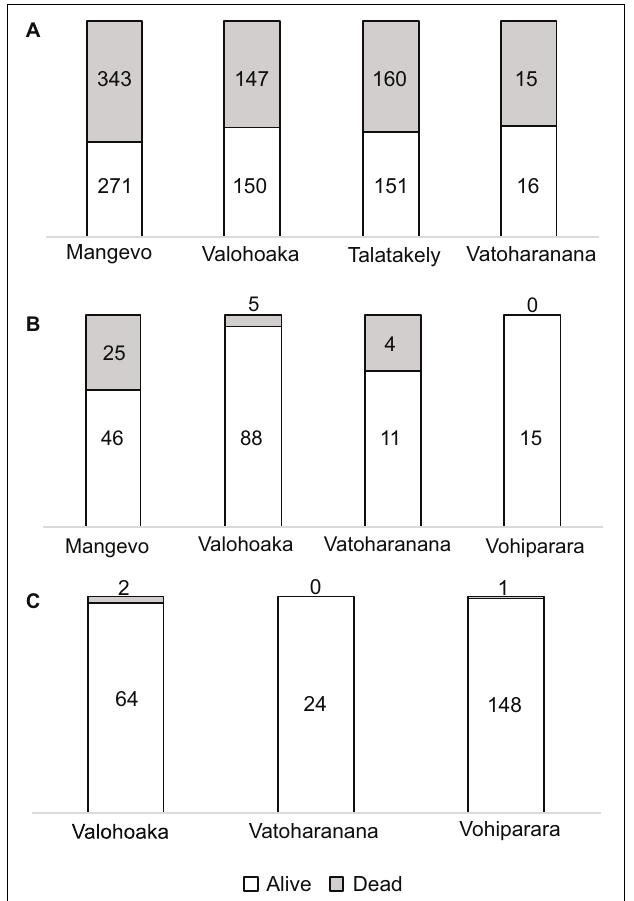
FIGURE 4 | Proportion of dead (gray) and alive (white) trees per species of Calophyllum per site surveyed: (A) Calophyllum paniculatum , (B) Calophyllum milvum , and (C) Calophyllum drouhardii . Numbers within column represent the number of trees in each category.